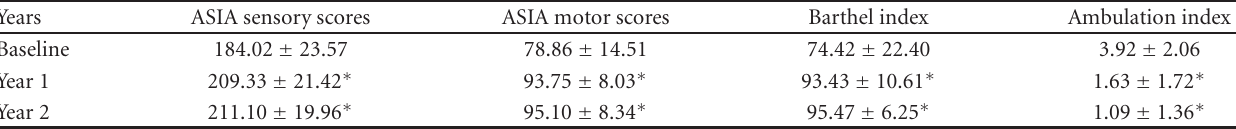
Table 2: The changes of spinal function scores on baseline and after 1 year and 2 years of ATT (51 patients).